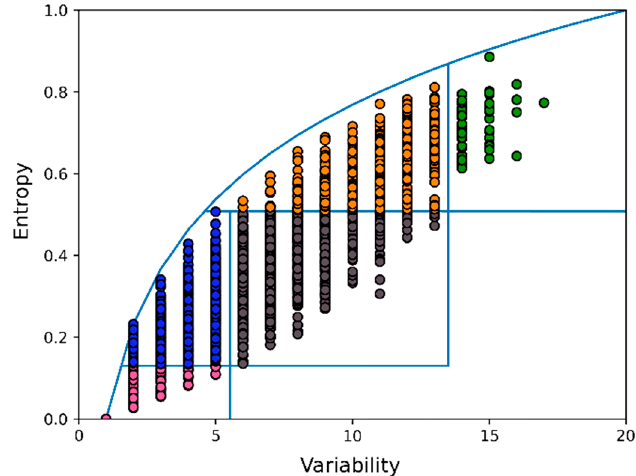
Figure 1. Example EV plot. Colours correspond to functional classes. Each circle represents one column in the MSA, and in this example, thus also one position in the structure. Oliveira et al. divided the EV plot in five areas that—from bottom left to top right—are called Box 11 (pink), 12 (blue), 22 (grey), 23 (orange), and 33 (green). Residue positions in Box 11 were mostly involved in the protein’s main function, while Box 12 residue positions were found in the 3D structure around Box 11 residues. Residue positions in Box 23 were generally associated with modulation (such as ligand-binding residues in receptors, calcium-binding residues in calcium-modulated proteins, etc.). Residue positions in Box 22 tended to be in the 3D structure between residue positions from Box 12 at the one side and residue positions from Box 23 at the other. Residue positions in Box 33, finally, tended to have no discernible function.